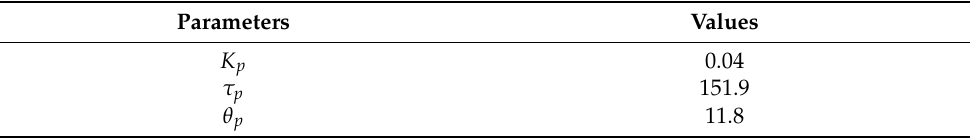
Table 3. FOPDT process